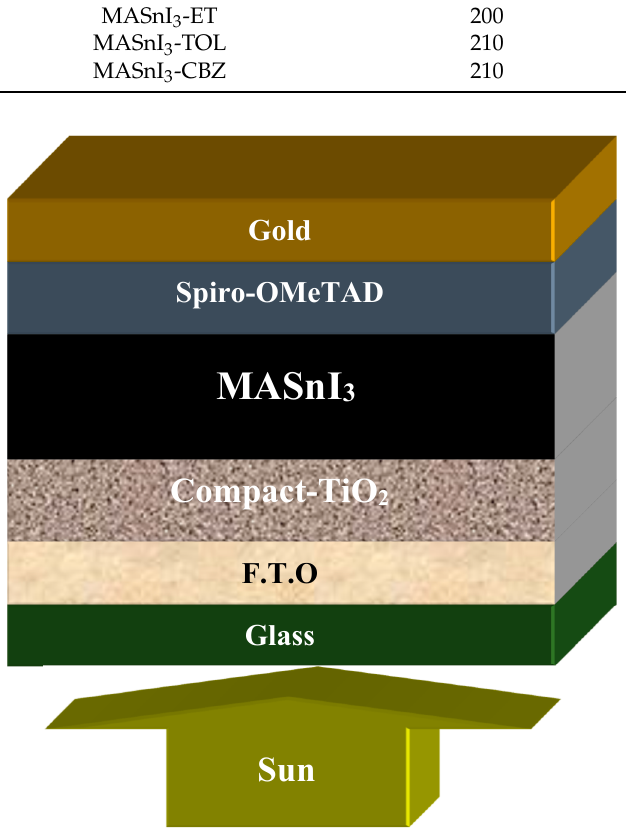
Figure 5. Schematic of a MASnI 3 -based solar cell structure.